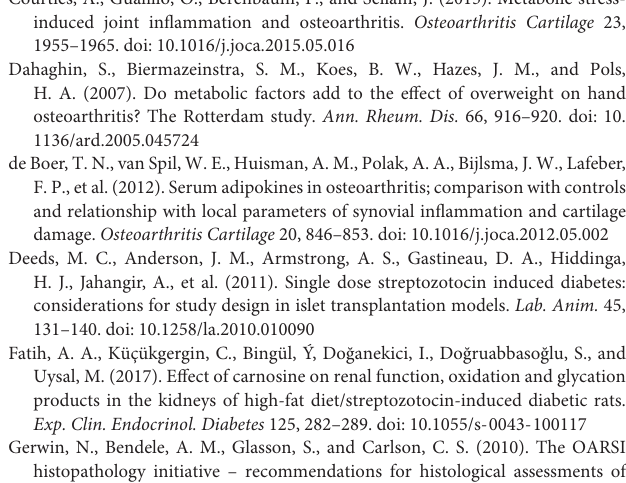
FIGURE S1 | FLSs were isolated from the knee joints of rats. Representative immunofluorescence image of FLSs stained with vimentin (green). Nuclei were stained with DAPI (blue). Scale bar, 50 µ